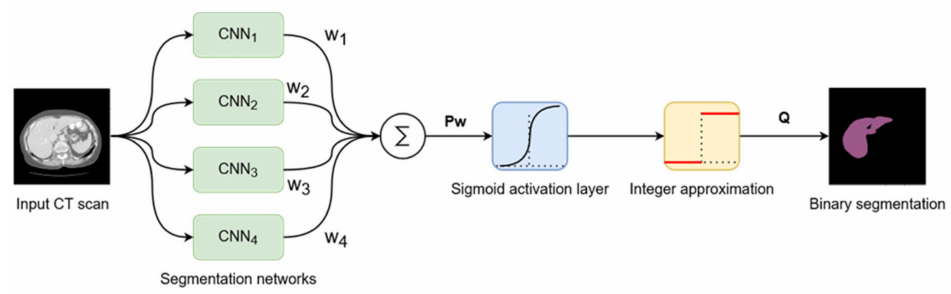
Figure 6. Modular representation of the decision fusion